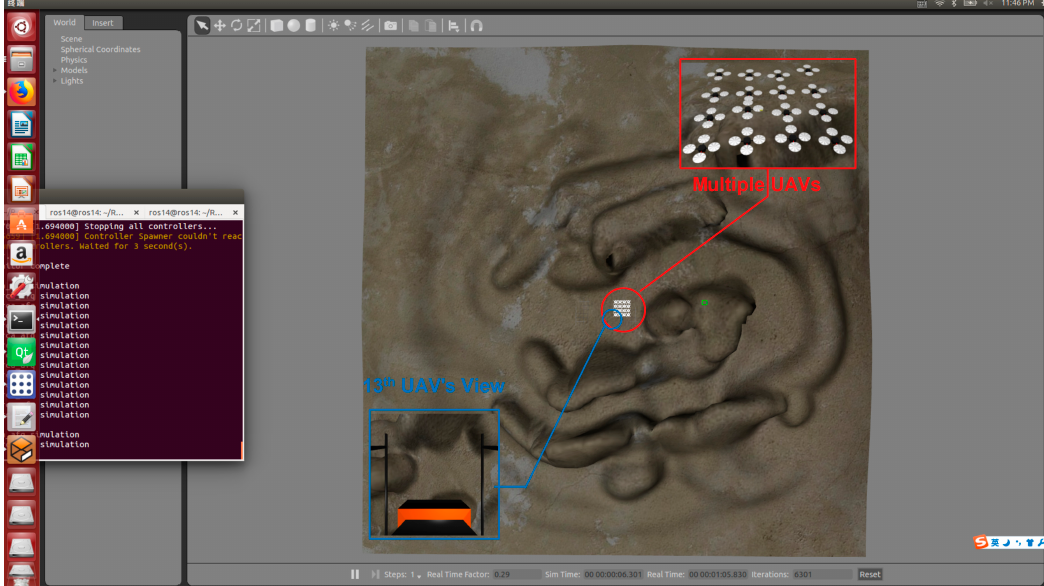
Figure 22. A screenshot of the simulation on Gazebo.